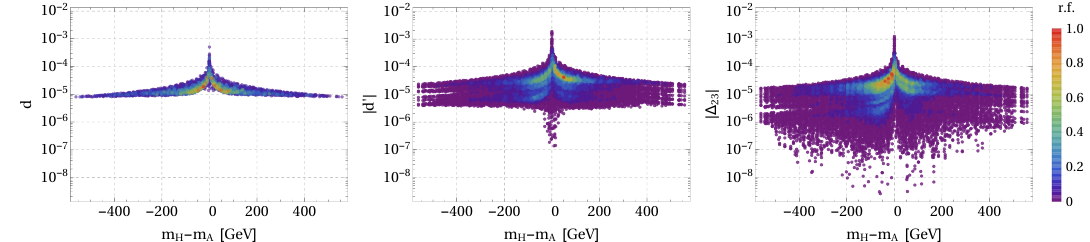
Figure 5 . (Color online) Scatter plot of the values of the parameters d and j d 0 j (left and center) and the Yukawa coupling j (cid:1) 23 j (right) as a function of the Higgs boson mass di(cid:11)erence m H (cid:0) m A . We used m 4 = 10 5 GeV, and (cid:21) D = 1 for this plot. 5000 points of the Higgs sector are used to have better statistics. The points are colored according to their normalized relative frequency (r.f.) of occurrence.